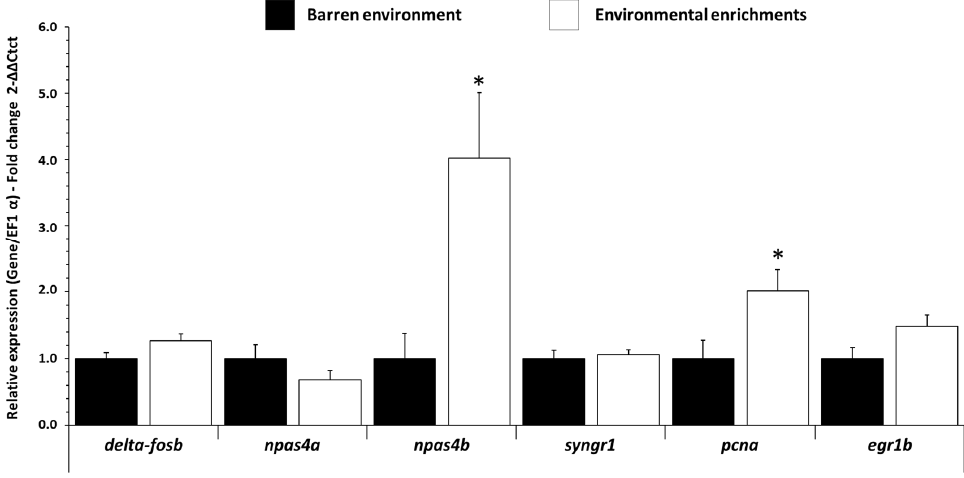
Figure 2. Neuronal activity related mRNA level in forebrain of trout raised in a barren environment (black) or environmental enrichments (white) for three months. Values are expressed as group mean ± SEM; fold change vs. barren environment for all genes; Welch’s t ‐ test, Tukey post hoc; differences between treatments are represented by * ( p < 0.05). Replicates (n = 8) correspond to different indi ‐ vidual fish.